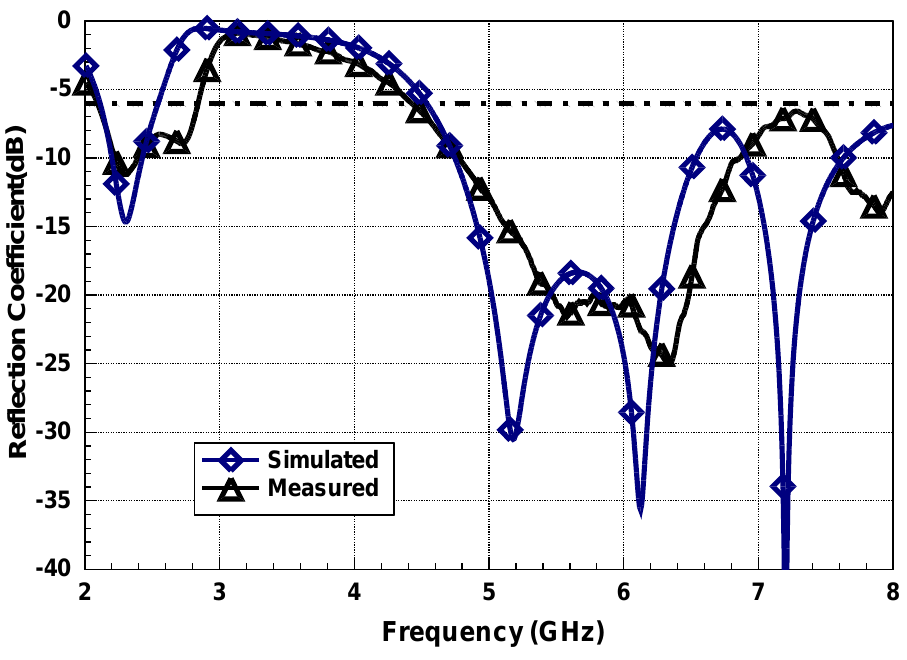
Figure 3. The verification result of the reflection coefficient with simulation and measurement for the proposed monopole antenna.